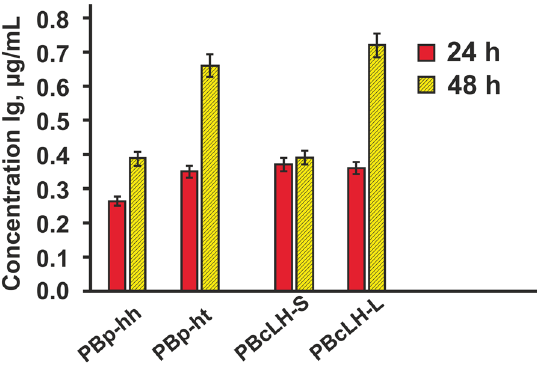
Fig. 2 Сomparative analysis of the IgG expression level of different vector construction. Transient transfection in CHO-DG44 cells.